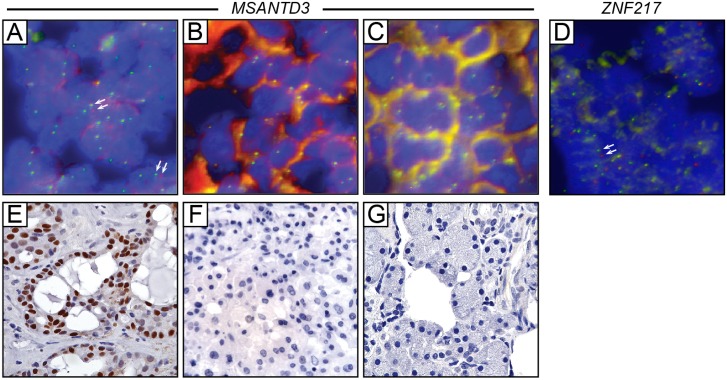
Evaluation of MSANTD3 rearrangement and protein expression in accinic cell carcinoma tissue sections.(A-C) Break-apart FISH assay of MSANTD3 locus rearrangement; green FISH probe is flanking centromeric and red FISH probe is flanking telomeric to MSANTD3. Note positive rearrangement (evidenced by physically-separated green and red signals, arrows) in AcCC case (A). AcCC case (B) is negative for the rearrangement (i.e., signals co-localize), as is observed in normal salivary gland control (C). (D) Break-apart FISH assay of ZNF217 rearrangement, confirming the rearrangement in the index case. (E-G) Corresponding MSANTD3 immunostaining of the above cases. Note the strong nuclear MSANTD3 staining (E) corresponding to the FISH-positive rearranged specimen.